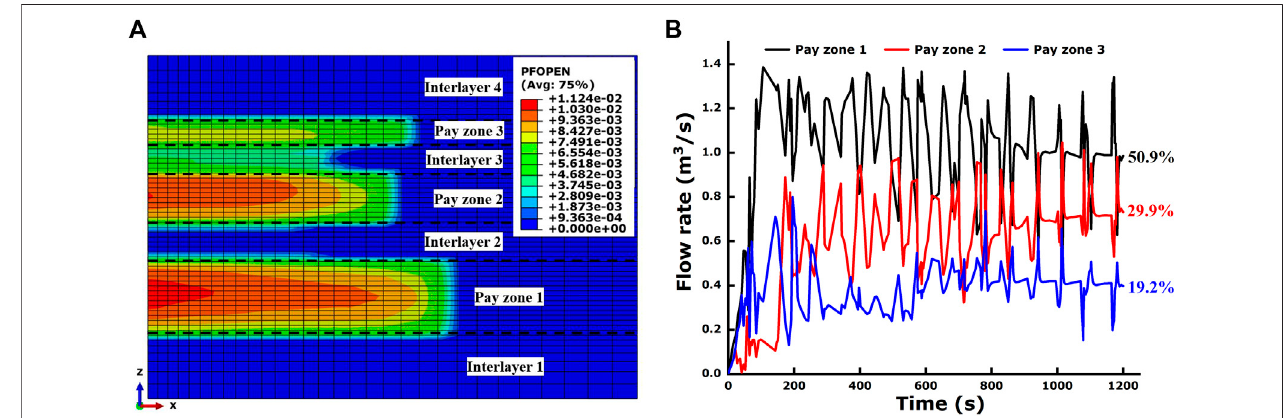
FIGURE 14 | Fracture geometry and fl ow rates of fl uid into pay zones with new rock strength of pay zone 3. (A) Hydraulic fracture geometry; (B) Flow rates of fl uid into the three pay zones.